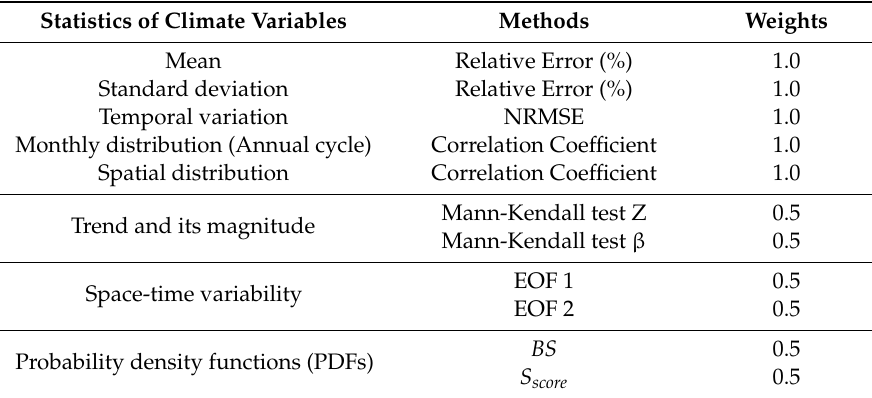
Table 1. Statistics of climate variables used for GCM performance